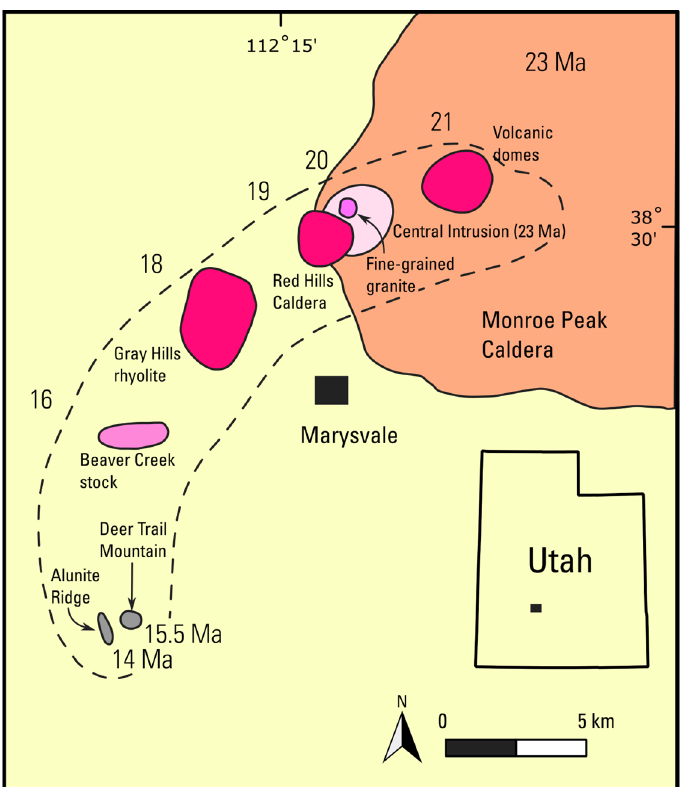
Figure 2. Schematic map showing the spatial and temporal migration of volcanic sources within the eastern source area (indicated by the dashed line) of the Mount Belknap Volcanics in the Marysvale volcanic field. Figure after Cunningham et al. [14] (see also Cunningham et al. [16] for detail of the Central intrusion). See Figure 1 for location.